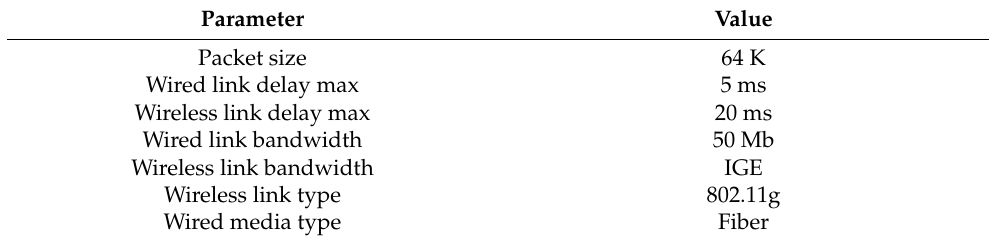
The red color line shows the transmission time in the wireless link. The blue color